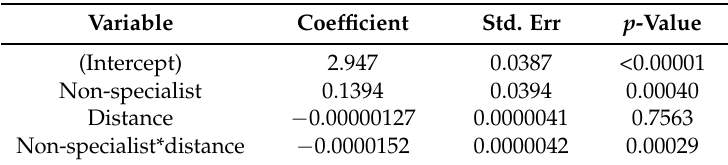
Table 3. Regression table for the model of agreement with the majority classification of an image as a function of distance of that image from a participant’s home and professional background. The coefficient is either an absolute difference in probability correct or a change in probability correct/km where distance is involved in a term. The asterisk symbol (*) denotes an interaction between two